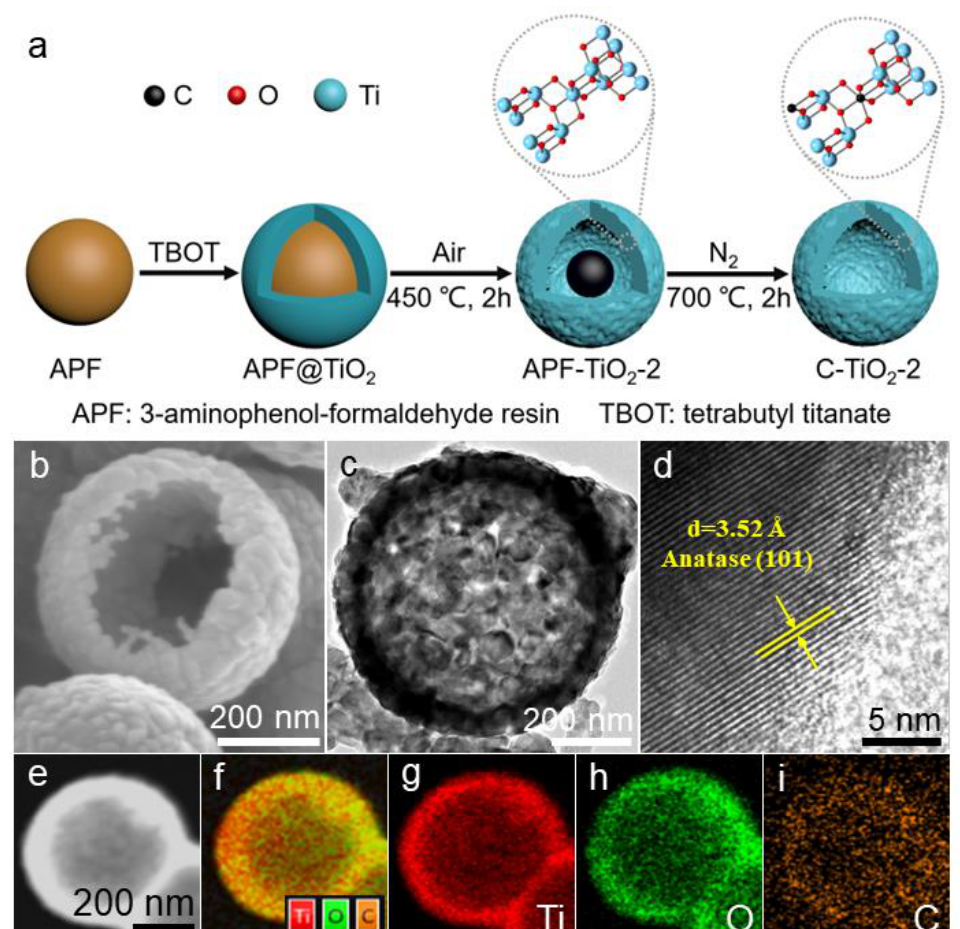
Figure 1. ( a ) Schematics showing the processes of synthesizing C-modified hollow photocatalysts (C − TiO 2 − 2). ( b – d ) SEM, TEM and HRTEM images of the C − TiO 2 − 2 photocatalyst. ( e – i ) EDS mapping images of C − TiO 2 − 2 photocatalyst.